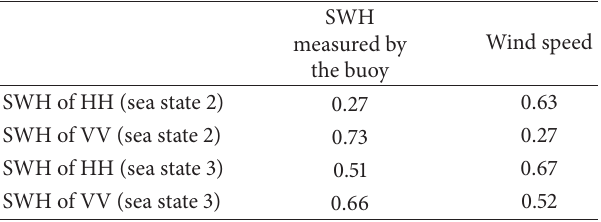
Table 3: Division of the sea states. Table 4: The correlation coefficients between the SWH measured by the buoy and those retrieved from first principal components of HH and VV polarized radars, and the correlation coefficients between thewindspeedsandtheretrievedSWHinRegionA2underdifferent sea